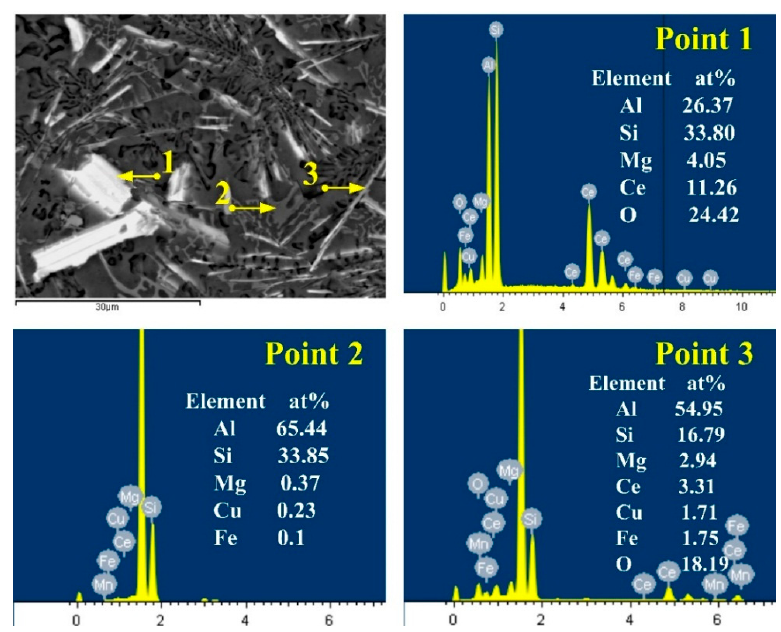
Figure 6. Energy dispersive spectrometer (EDS) point scanning results of point 1, point 2, and point 3 from the TRC alloy fabricated with the traditional twin-roll casting process.